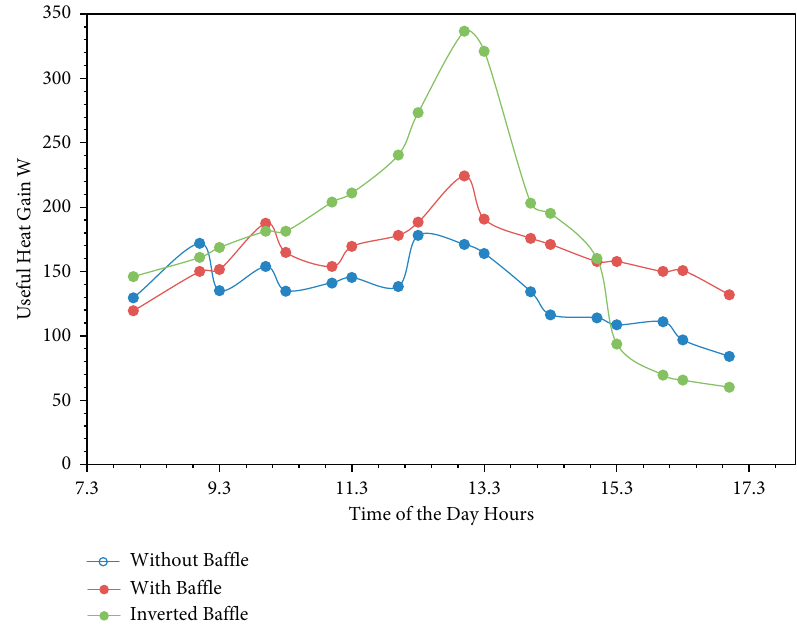
Figure 4: Useful heat gain for SAH without, with zinc -ferrite nanocoated bafe, and inverted bafe plate.